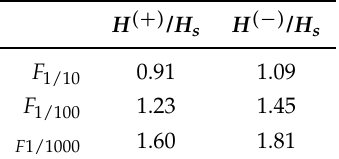
Table 4. Virtual wave heights H (+) and H ( − ) in front of a U-OWC, in the interval 0.15 < d / L p 0 < 0.20.